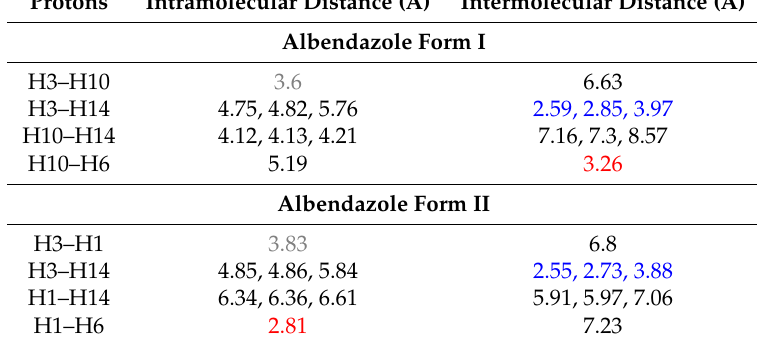
Table 1. Intramolecular and intermolecular 1 H - 1 H distances in ABZ I and ABZ II. The distances corresponding to the blue are measurable unambiguously and those in red can be measured but they are measured out of overlapped resonances. The distances in gray are sufficient to differentiate between the two